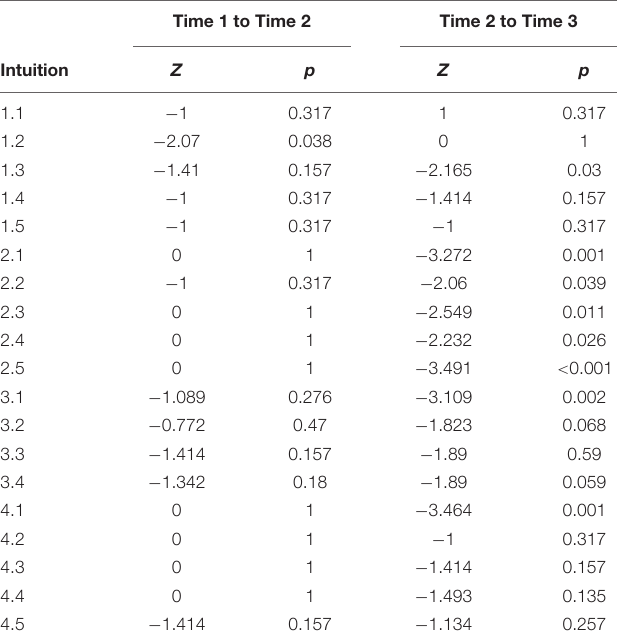
TABLE 4 | Wilcox Rank Sign Test for student misconceptions at baseline (Time 1), at last mention immediately before exposure to cat’s eye program (Time 2), and after exposure to cat’s eye program (Time